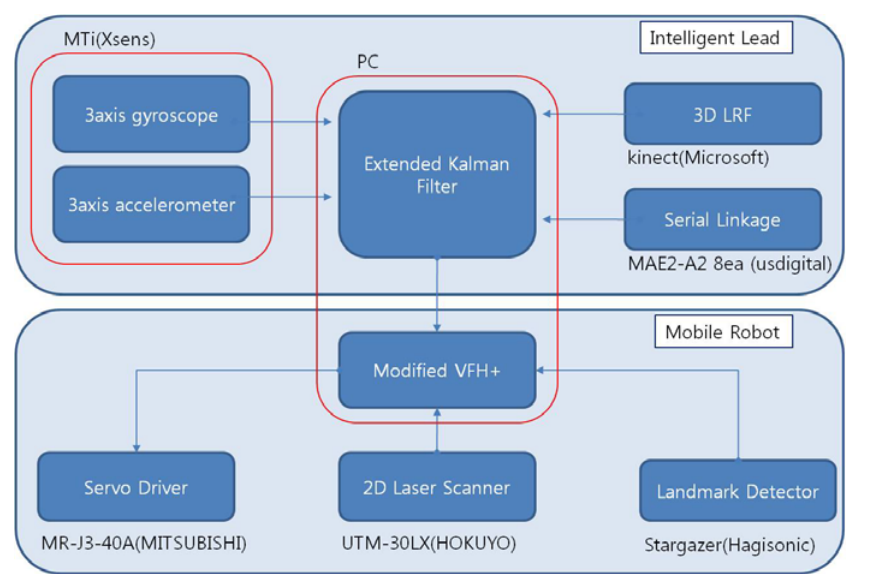
Figure 2. Block diagram of a proposed intelligent lead and a mobile robot for